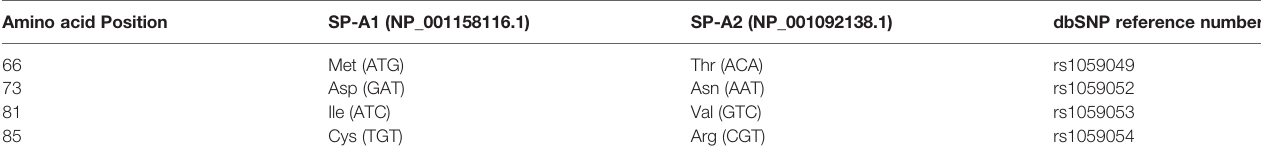
TABLE 1 | Amino acids differences and their respective codons in parenthesis that distinguish the two human SP-A1 and SP-A2 gene products and their corresponding coding variants. Amino acid Position SP-A1 (NP_001158116.1)